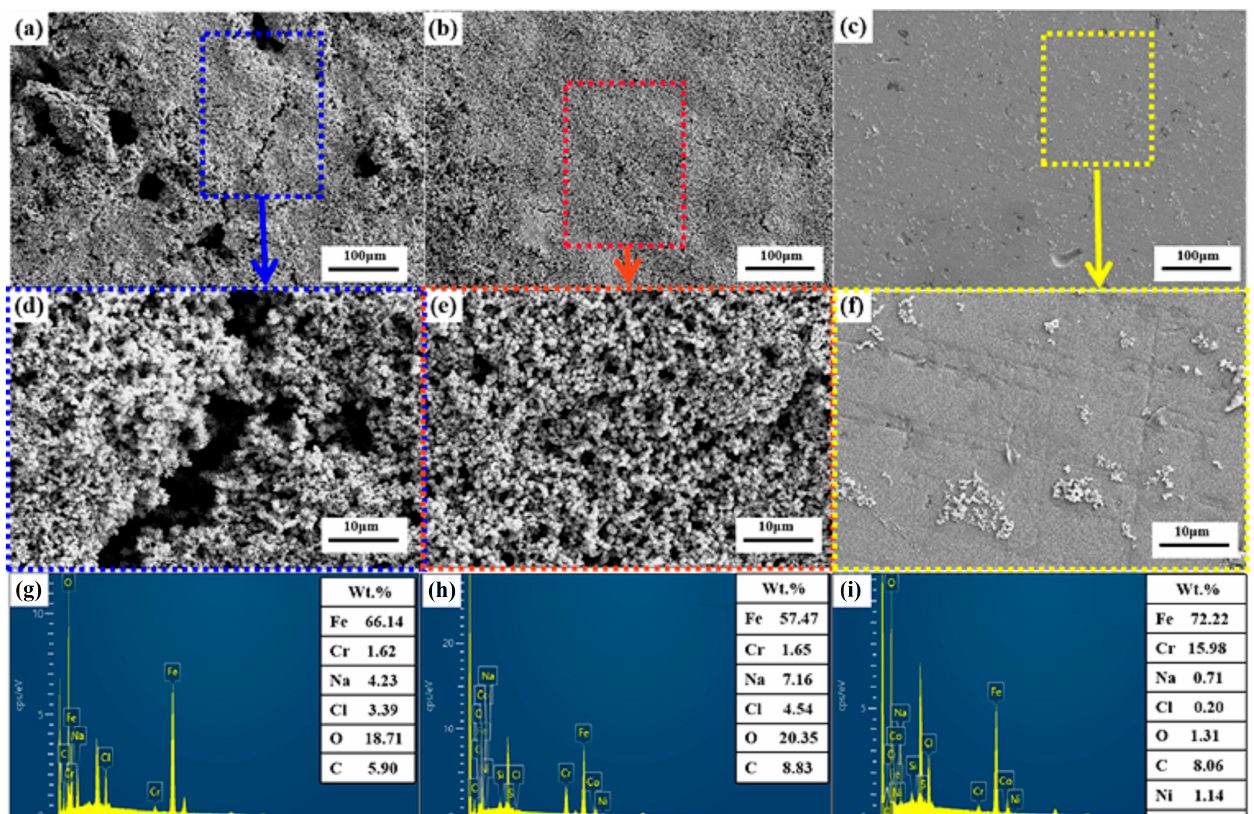
Figure 11. Morphologies of coatings immersed for three days and EDS scanning analysis: ( a , d , g ) Fe- based coating, ( b , e , h ) 6% γ -Fe coating, and ( c , f , i ) 9% γ -Fe